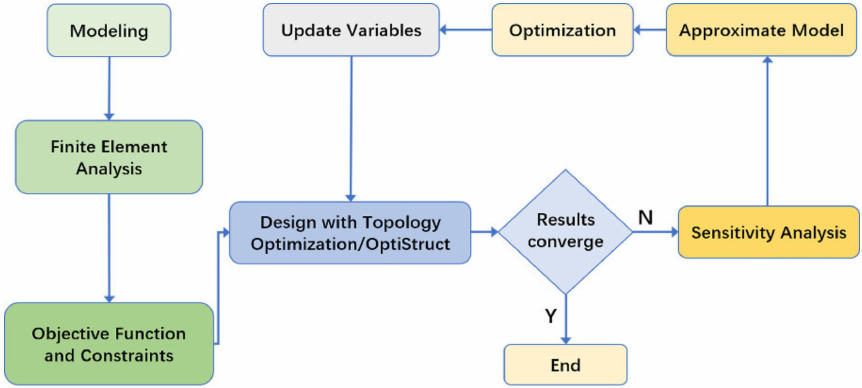
Figure 2. Topology optimization